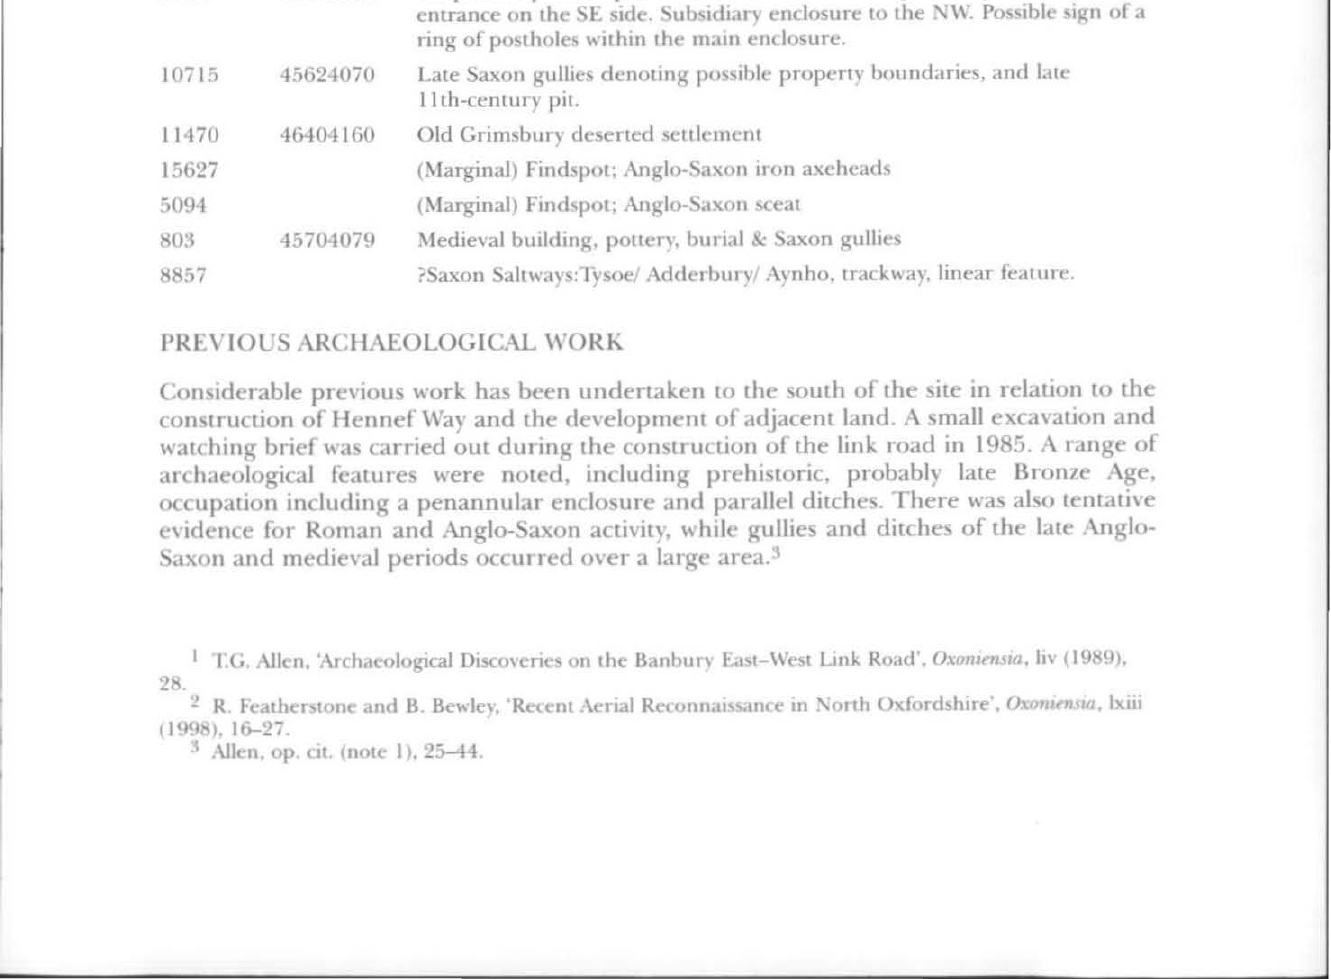
TABLE I, SMR D~.I.\ILS DetaJIJ Cropmark: pos\ible prehi'ilOnC enclosure. Rectangular in plan \\-ith all entrance on the Sf. side. Sub'ldidf) enclosure to the ~\\'. Possible 'iign of a nng of pO\lholes wi. hill the millll